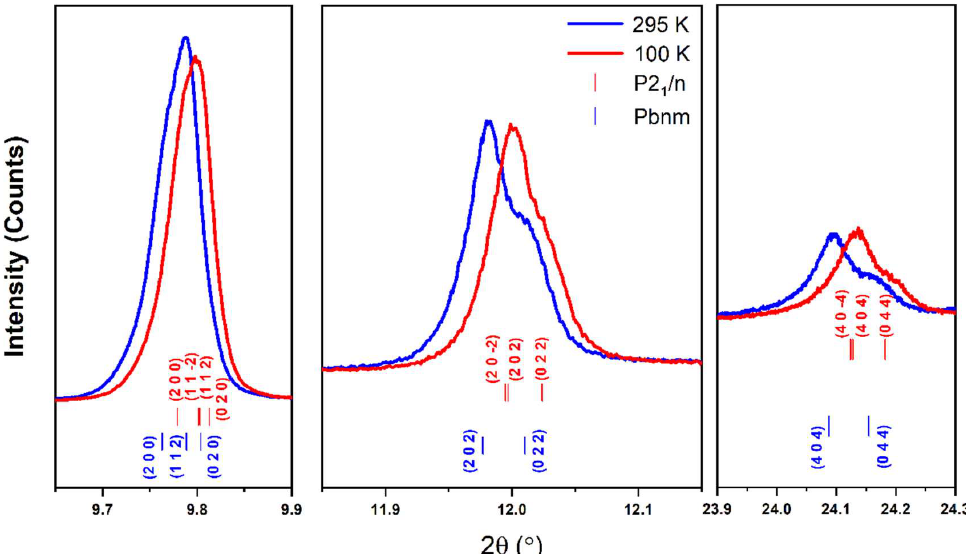
Figure 7. High-resolution synchrotron X-ray powder diffraction intensities of as-grown NdNiO 3 in the 2 θ range of 9.65–9.9 ◦ , 11.85–12.15 ◦ , and 23.9–24.3 ◦ measured at 100 K ( λ = 0.458956 Å) and 295 K ( λ = 0.458961 Å). Blue (bottom) and red (top) bars correspond to Pbnm and P 2 1 / n , respectively.